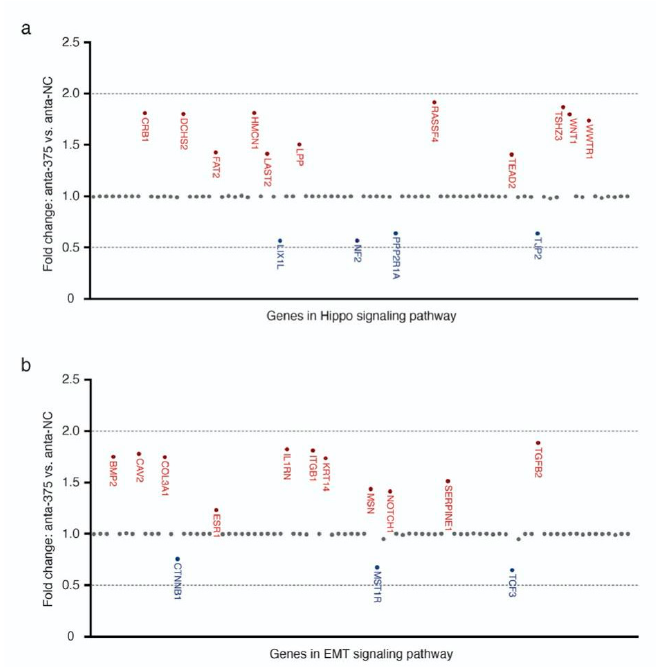
Figure 4. Moderate changes in the expression of Hippo ( a ) and EMT ( b ) signaling pathway-related genes by miR-375